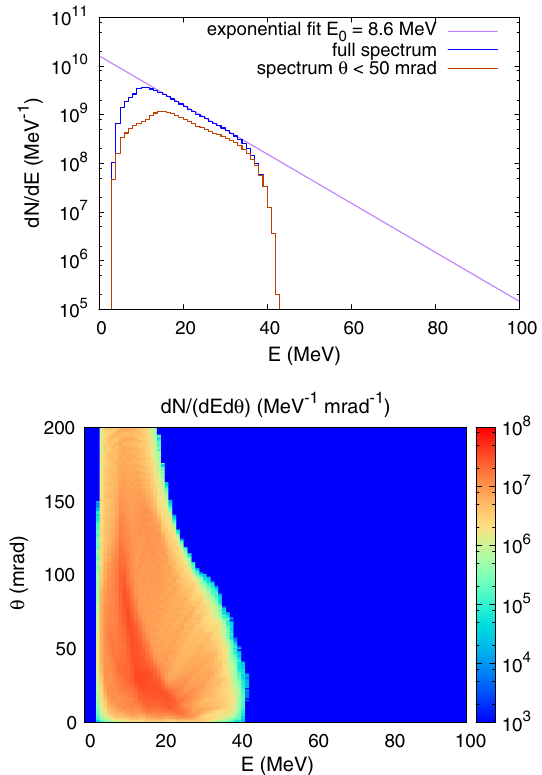
FIG. 1. Upper frame: Plot in a logarithmic scale of the proton initial energy spectrum (blue line) and after an angular selection (cid:7) < 50 mrad (light brown line) for the mass limited target (TNSA) with a ¼ 30 . The values refer to the actual number of particles; the energy interval is divided into 100 bins so that each energy bin corresponds to (cid:1) E ¼ 1 MeV . Lower frame: Initial energy-angle distribution of the bunch in a logarithmic color scale. The energy range is divided into 100 bins, while the angular range is divided into 200 bins, so that each energy bin corresponds to (cid:1) E ¼ 1 MeV , each angle bin to (cid:1) (cid:7) ¼ 1 mrad .